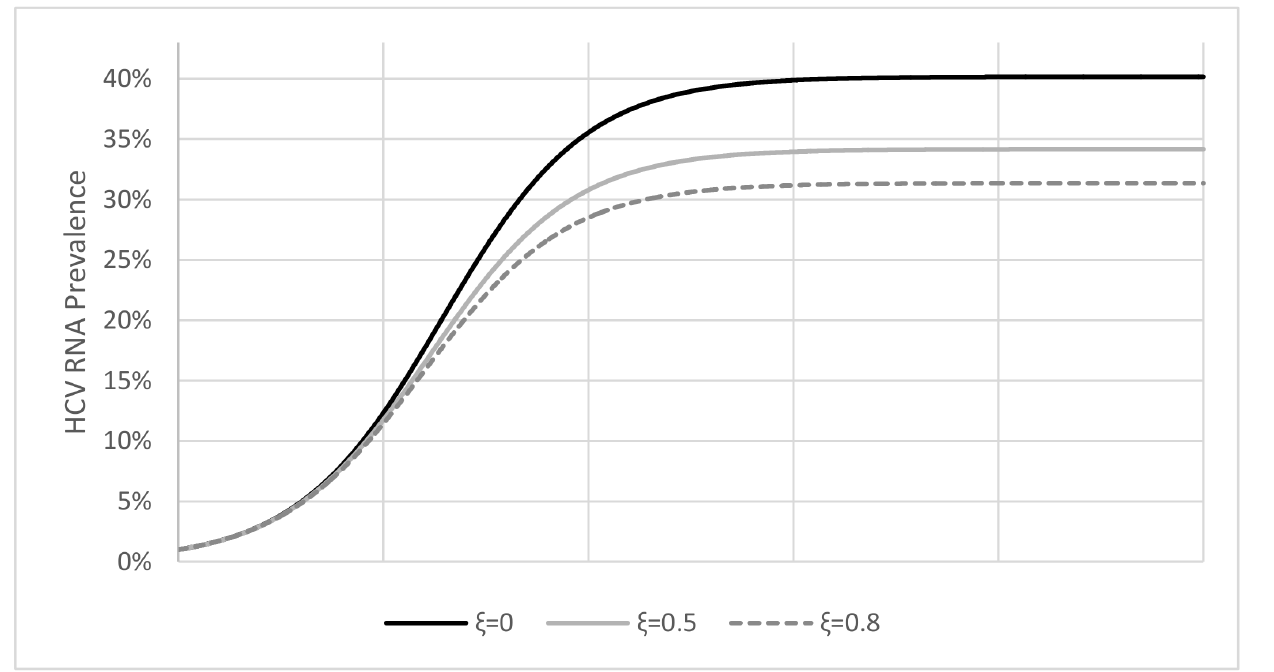
Fig 2. The effect of immunity (parameter ξ ) on HCV-RNA prevalence. With no immunity (i.e., ξ = 0) HCV-RNA prevalence reaches steady state at 40% (solid black line). When 50% or 80% of cases result in immunity, HCV-RNA prevalence reaches steady state at 34% (solid gray line) or 31% (dashed gray line), respectively. All other model parameters were set as shown in Table 1 and π = 0.192. The simulations were initiated with one HCV-infected individual until it reached steady state with no treatment scale-up. On the x-axis each rectangle represents 50